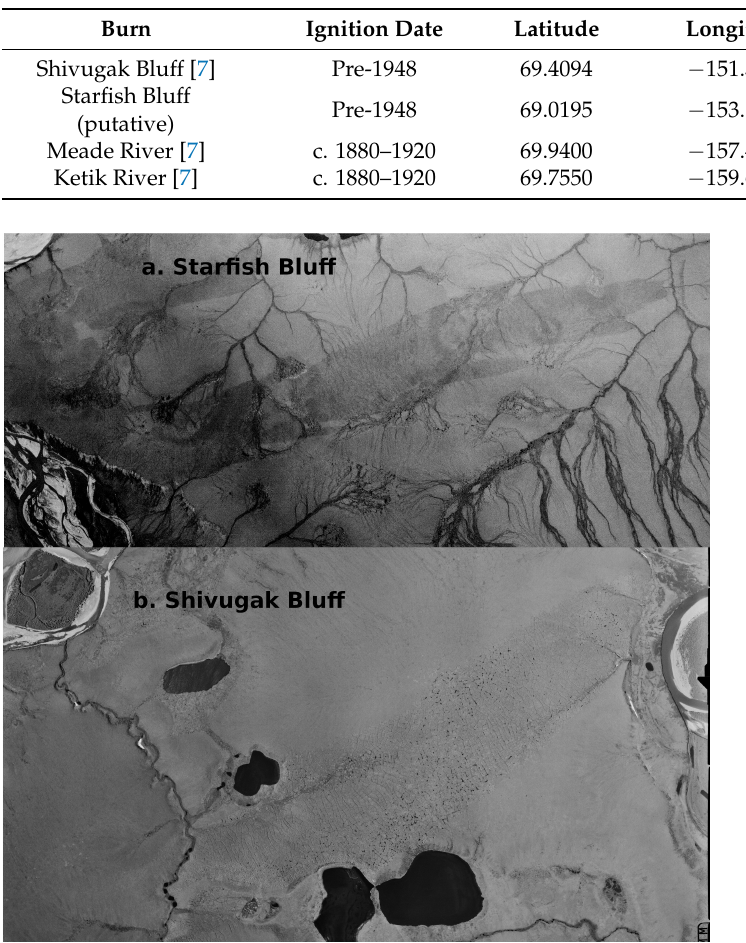
Figure 7. Aerial photographs of prehistoric burns. ( a ) Starfish Bluff Burn (putative); USGS Entity ID: ARHM04908911505, Acquisition Date: 26 June 1955. ( b ) Shivugak Bluff Burn; USGS Entity ID: ARCBAR000540063, Acquisition Date: 18 July 1948. Both burns are visible in contemporary